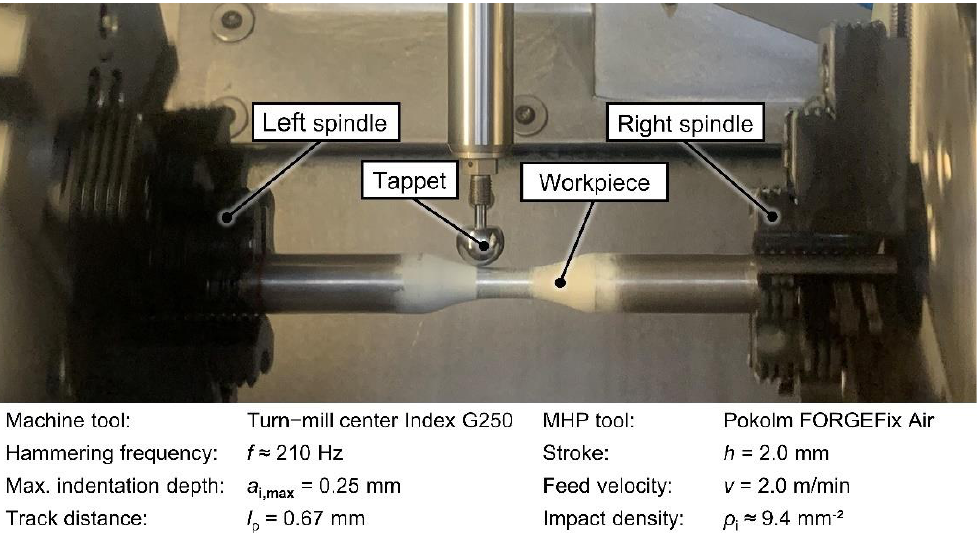
Figure 2. Setup of the machine hammer peening (MHP) process using turn-mill center index G250. The process parameter settings were chosen based on former studies [14,22]. A com- pressed air pressure p = 6 bar resulted in a hammering frequency f ≈ 210 Hz with a stroke set to h = 2.0 mm. A feed speed v f = 2.0 m/min, a maximal indentation depth a i,max ≈ 0.25 mm, and a line pitch l p = 0.67 mm were used. The process parameter resulted in an impact